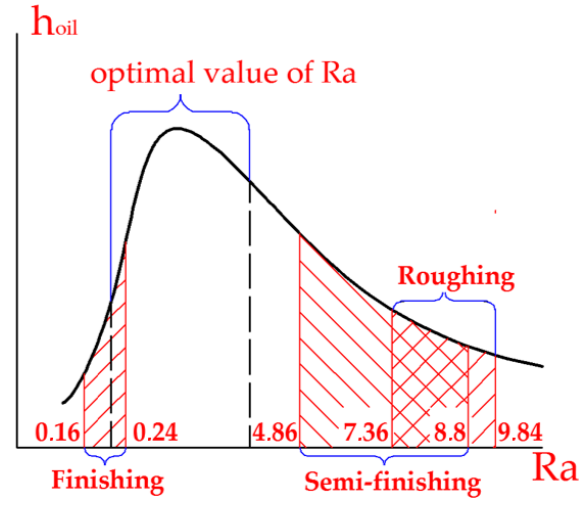
Figure 8. Roughness parameters provided by process operations.